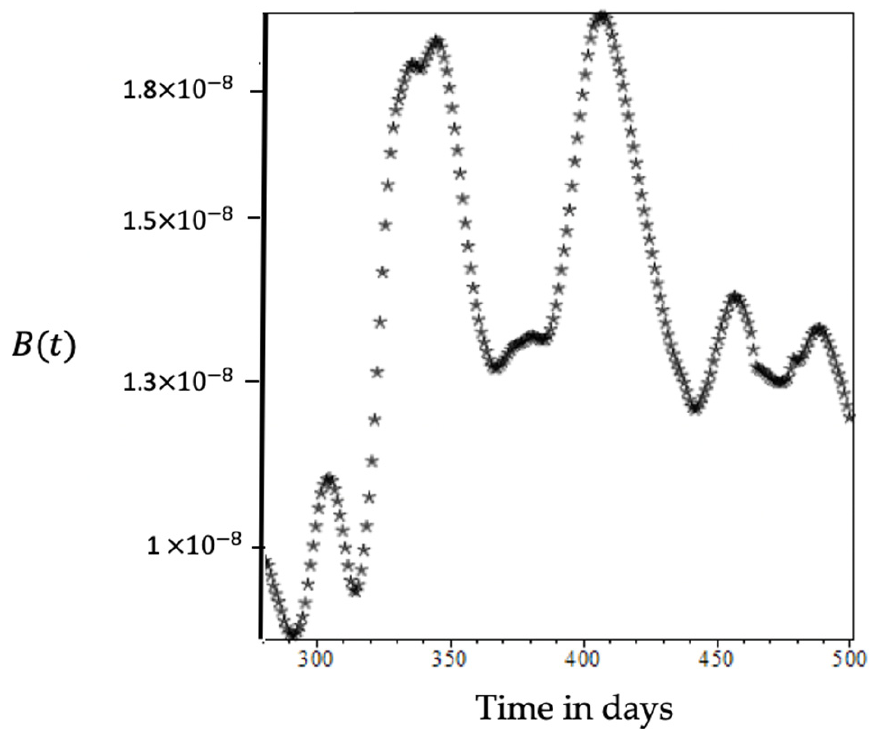
Figure 4. Time development of the transmission rate of the symptomatic population, 270 ≤ 𝑡 ≤ 500.